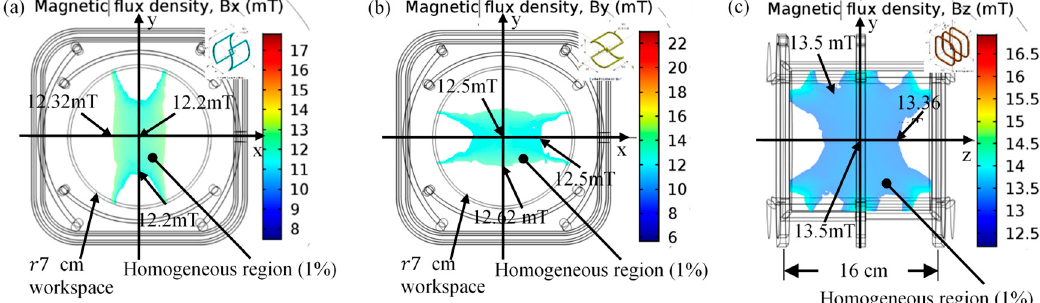
Figure 7. Homogeneous region of field uniformity field determined by Homogeneity in the x, y, z component on the defined workspace about r 7.5 × 16 cm 3 . Variability is set at about 1%. Magnetic field of each component at the center, B 0 , with 1% variance covers a distribution area. ( a ) x : 12.2–12.32 mT wide about 50 mm, ( b ) y : 12.5–12.62 mT wide about 50 mm, ( c ) z : 13.36–13.5 mT wide about 80 mm. The blue color areas represent the homogeneous region of magnetic field.